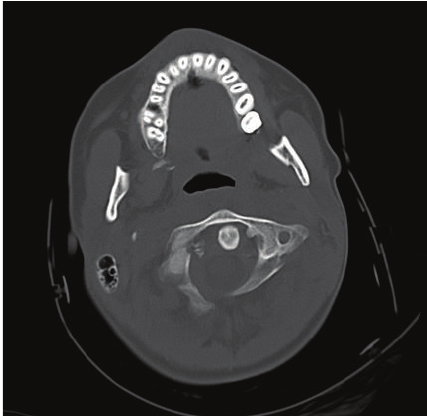
Figure 1: Axial CT reconstruction image shows avulsion fracture of the right occipital condyle (type III according to Anderson- Montesano classification).